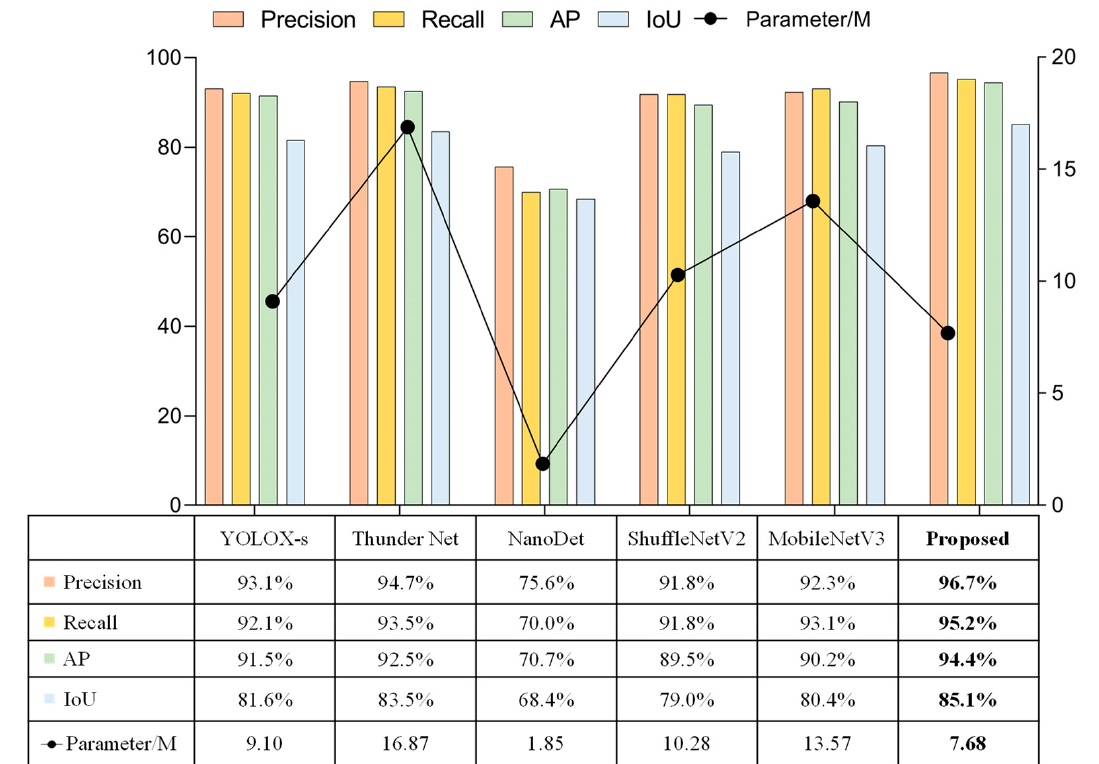
Figure 17. Experimental results of horizontal table capturing.